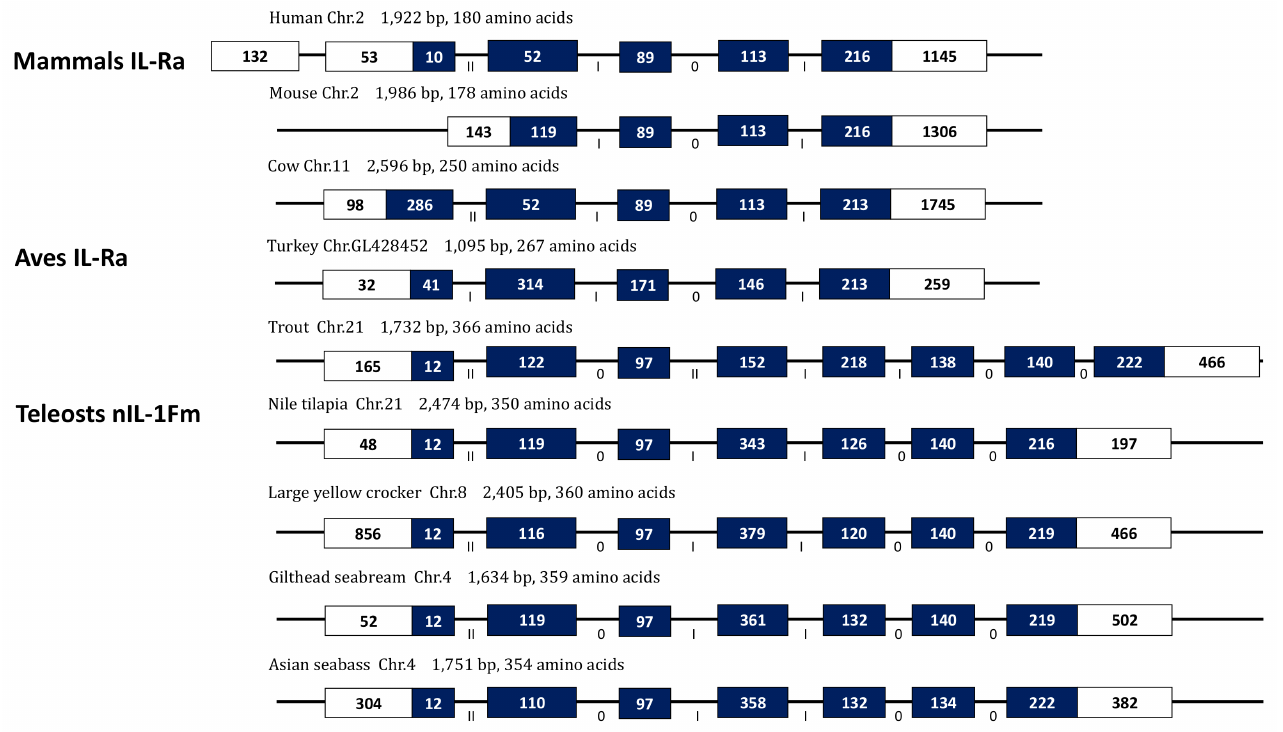
Figure 5. Comparison of the gene organization of Nile tilapia nIL-1Fm gene with nIL-1Fm genes of other fish or higher vertebrate IL-1Ra.